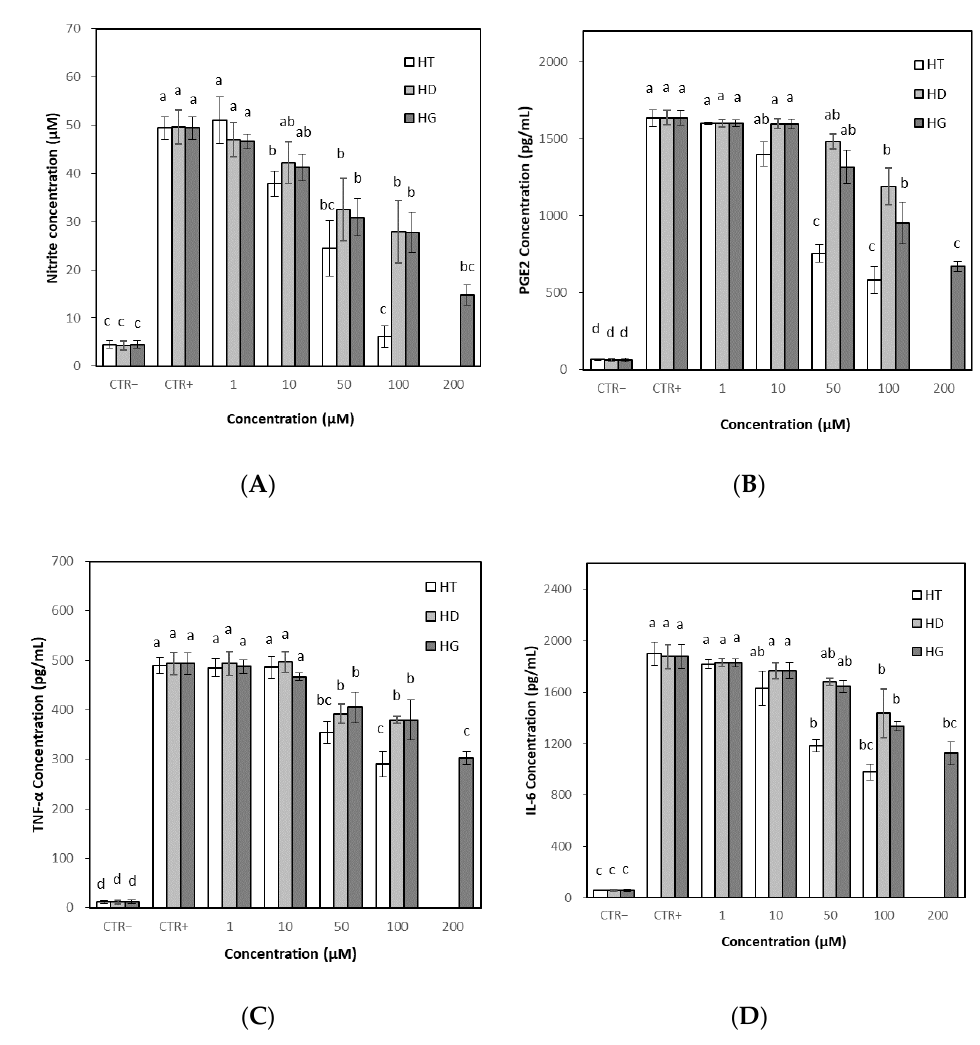
Figure 7. Effect of hesperetin, hesperidin and hesperidin glucoside on the production of nitric oxide (NO), Prostaglandin E2 (PGE2), tumor necrosis factor alpha (TNF-α) and interleukin 6 (IL-6). RAW 264.7 cells were cultured with different concentrations of hesperetin, hesperidin and hesperidin glucoside for 24 h with LPS (1 μg/mL). Results were represented as mean ± SD ( n = 3). ( A ) Effect on NO levels; ( B ) Effect on PGE2 levels; ( C ) Effect on TNF- α levels; ( D ) Effect on IL-6 levels. Different letters (a, b, c, d) above the bars indicate significant differences ( p < 0.05), where letters ab or bc indicate the intermediate significance between a and b, or b and c, respectively. CTR − ; Negative control, CTR+; Positive control (with LPS), HT; hesperetin, HD; hesperidin, HG; hesperidin